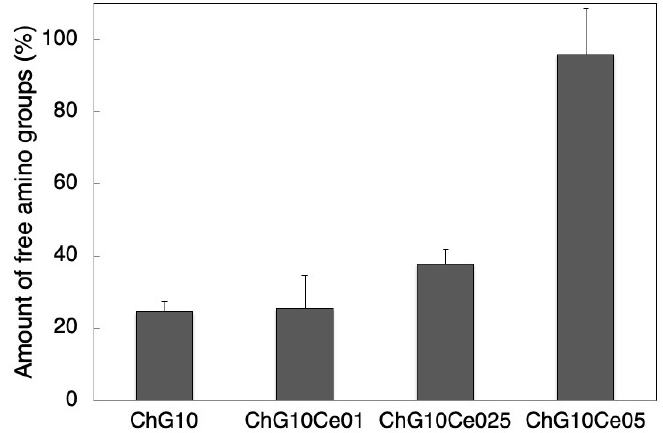
Figure 9. Percentages of free amino groups by ninhydrin reaction in ChG10 chitosan − siloxane hybrid spheres with various amounts of incorporated cerium chloride.